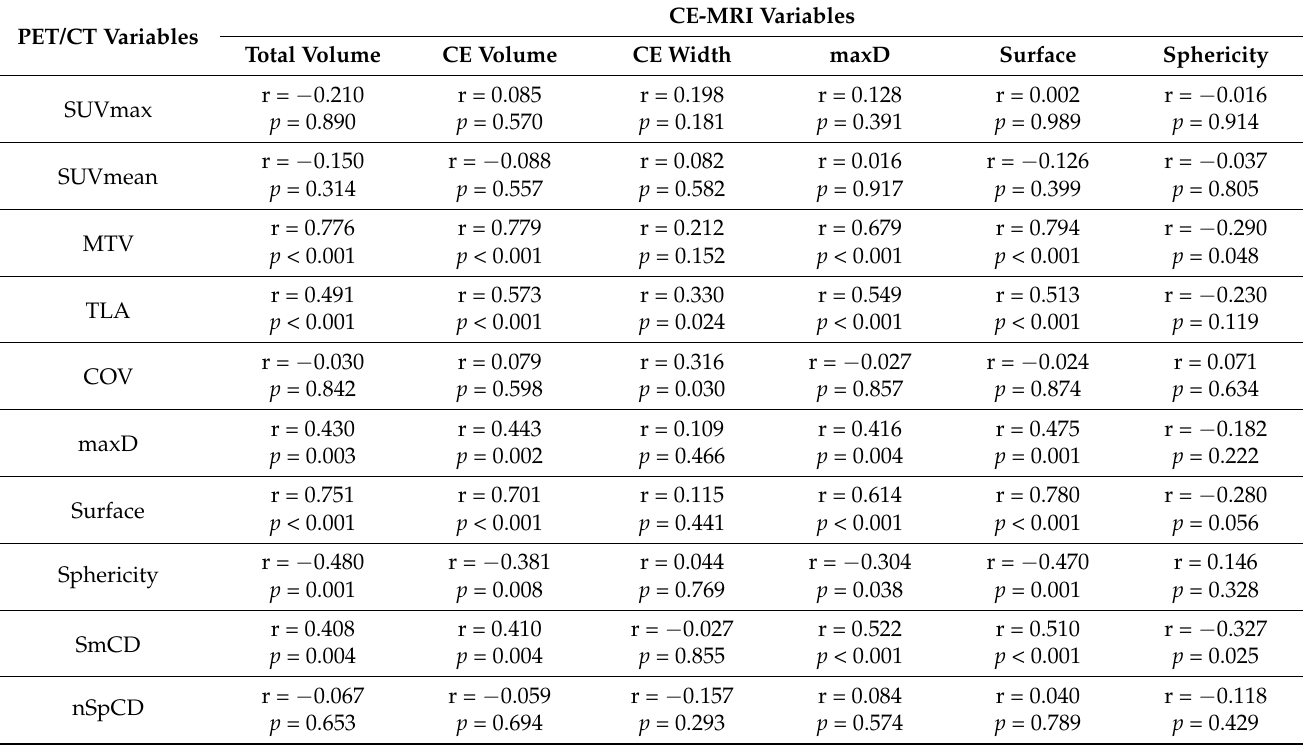
Table 3. Relation between 18 F-Fluorocholine PET/CT and T1-Gadolinium derived MRI variables. PET/CT Variables